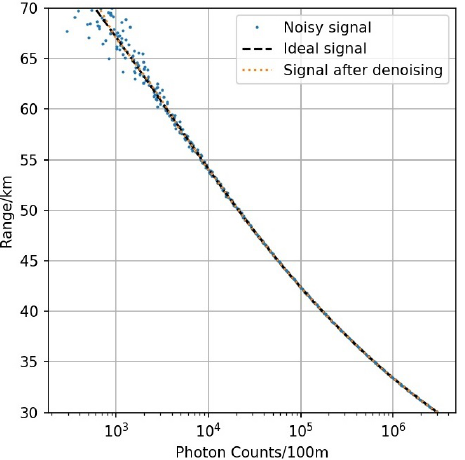
Figure 6. Denoising performance of WT-EEMD-LOWESS